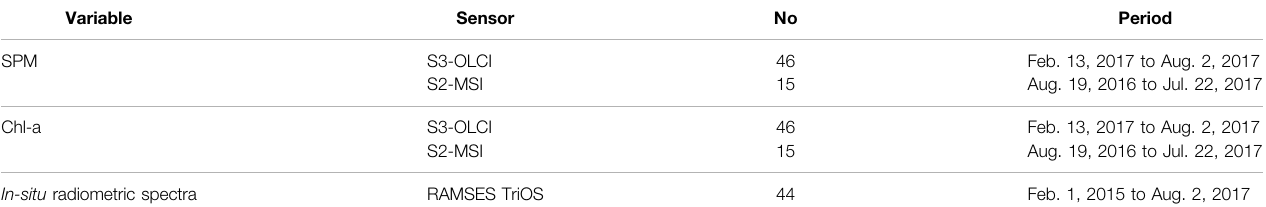
TABLE 1 | Water quality matchups.